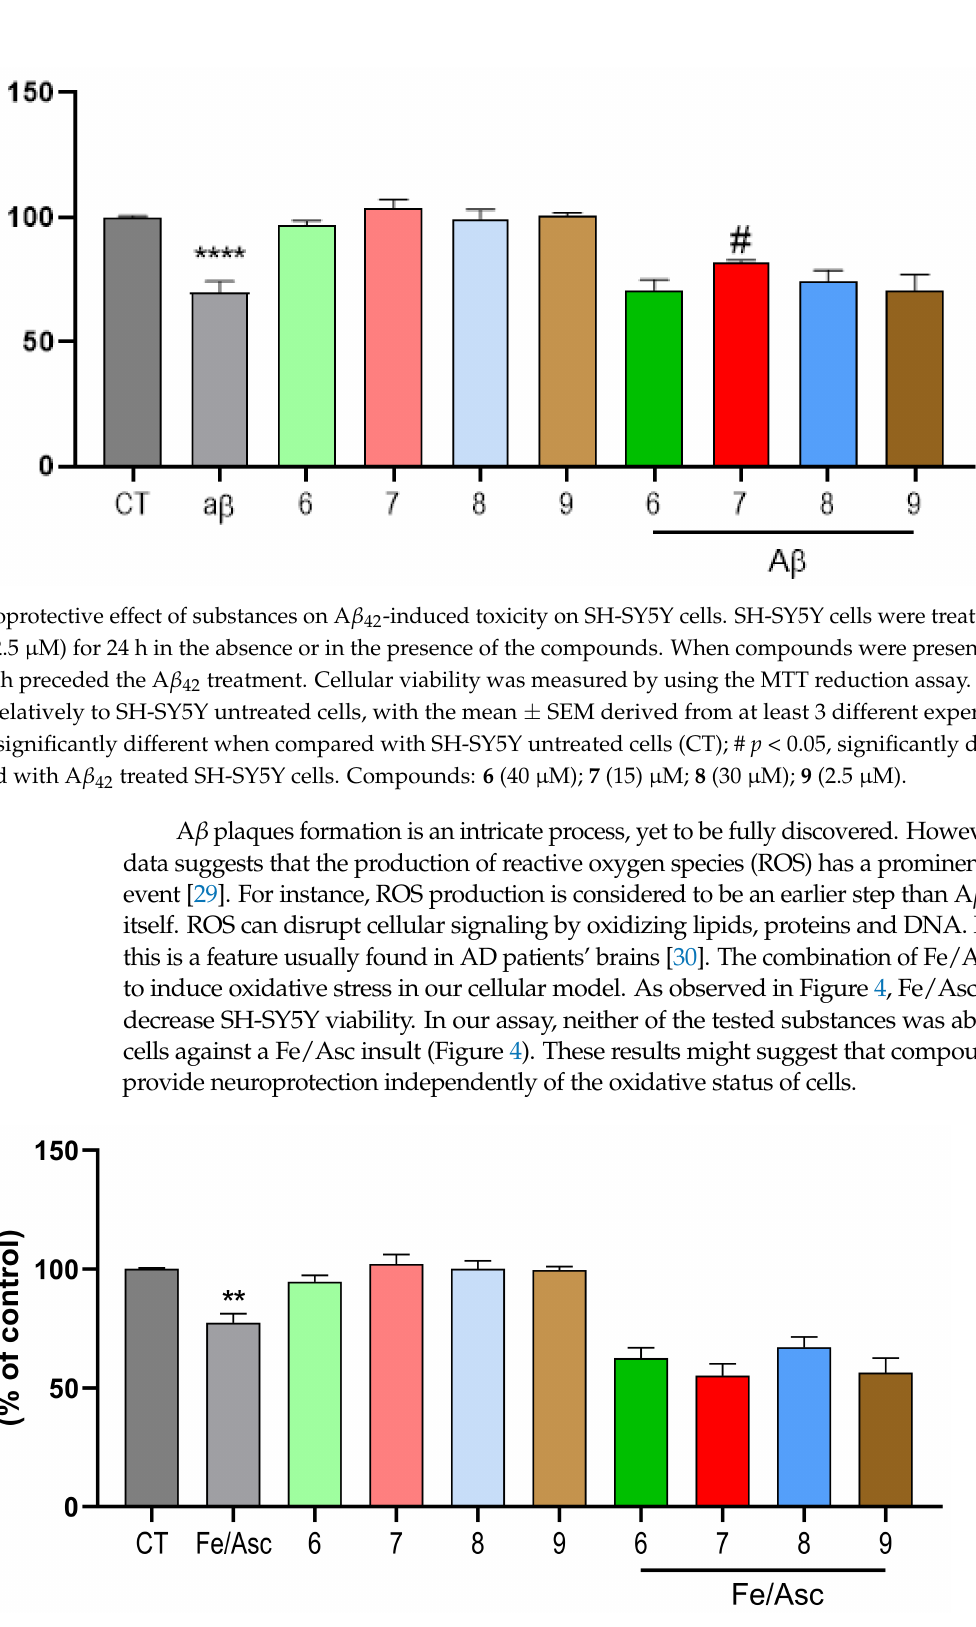
Figure 4. Neuroprotective effect of compounds on Ferrous Sulfate (Fe)/L-Ascorbic Acid (AscH( − ))-induced toxicity on SH-SY5Y cells. Overnight cultures were treated with Fe/Asc (2.5 M/5 mM, respectively) for 24 h in the absence or in the presence of the compounds. When compounds were present, a pre-incubation of 1 h preceded the A β 42 treatment. Cellular viability was determined by employing the MTT reduction assay. Results are expressed relatively to SH-SY5Y untreated cells, with the mean ± SEM derived from at least 3 different experiments. ** p < 0.01, significantly different when compared with SH-SY5Y untreated cells (CT). Compounds: 6 (40 µ M); 7 (15 µ M); 8 (30 µ M); 9 (2.5 µ